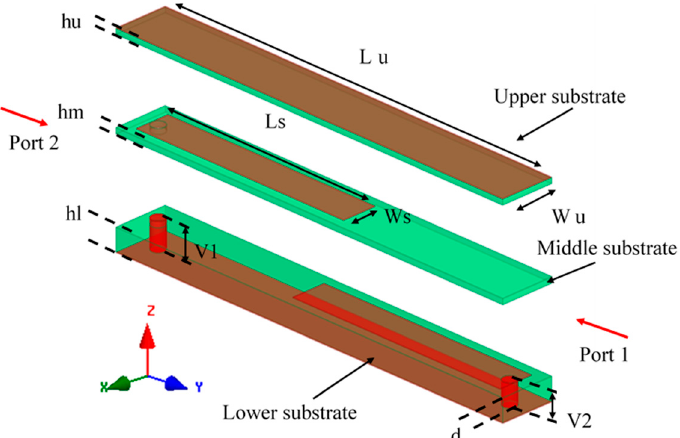
Figure 1. The proposed unit cell under specified boundary condition. The unit cell physical dimensions are Wu = 2.76, Lu = 23.5, Ws = 1.8, Ls = 13.65, d = 0.7, hl = 0.813, hm = 0.203, hu = 0.203. (all dimensions in mm).